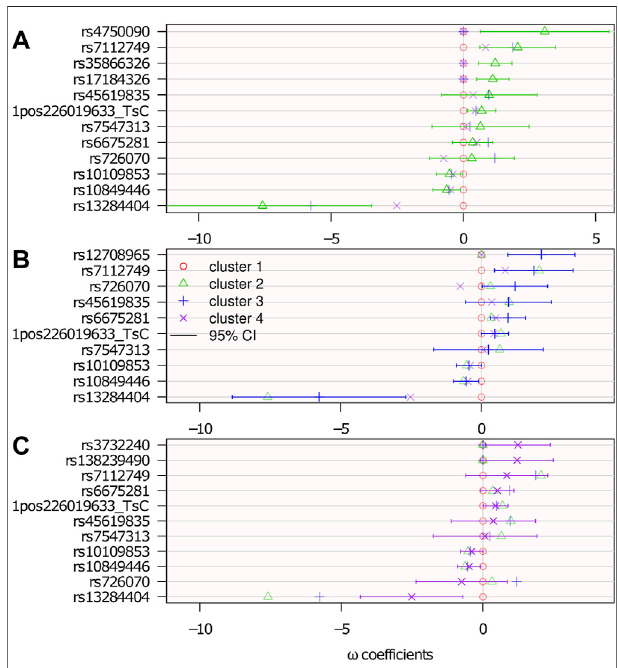
FIGURE 7 | Genetic association: estimated logistic regression parameters { ω }. Cluster 1 is the reference: ω ℓ =1 = 0 ; top (A) : ω ℓ =2 ; middle (B) : ω ℓ ω ℓ fi dence intervals are computed from the =3 ; and bottom (C) : =4 . The con Hessian matrix provided by the R function nnet::nnet (Ripley et al.,